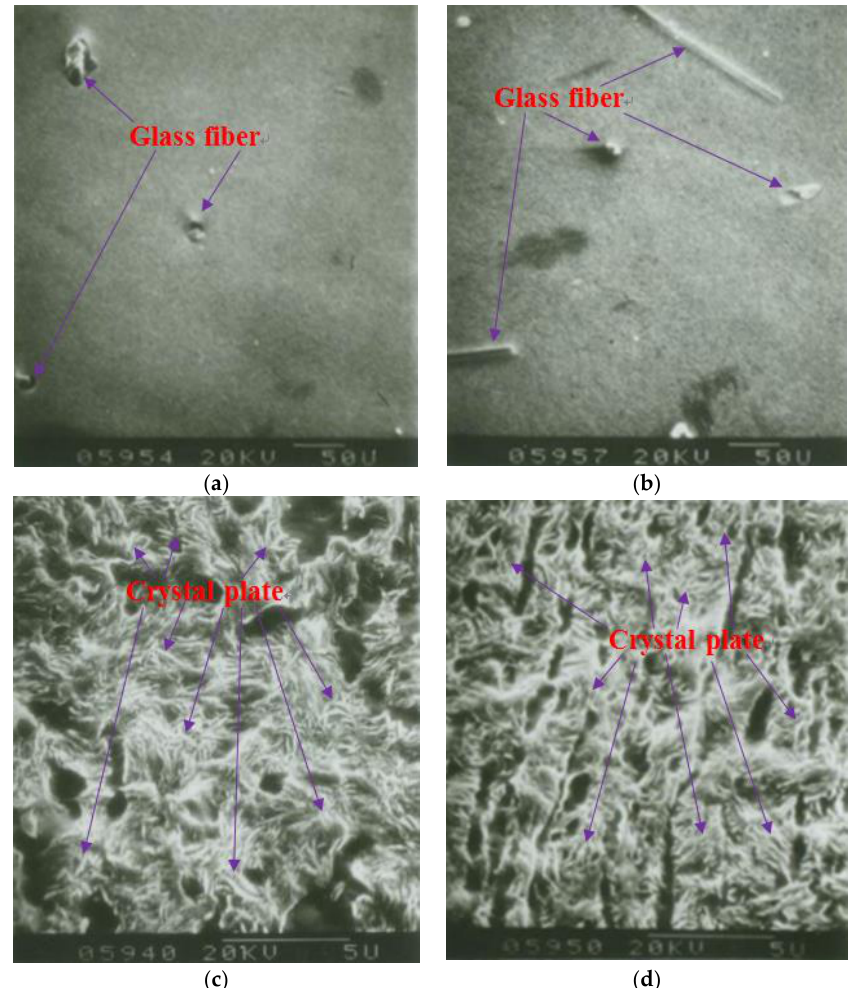
Figure 6. SEM micrographs of ( a , c ) conventional pipe and ( b , d ) reinforced pipe with 15 rpm.